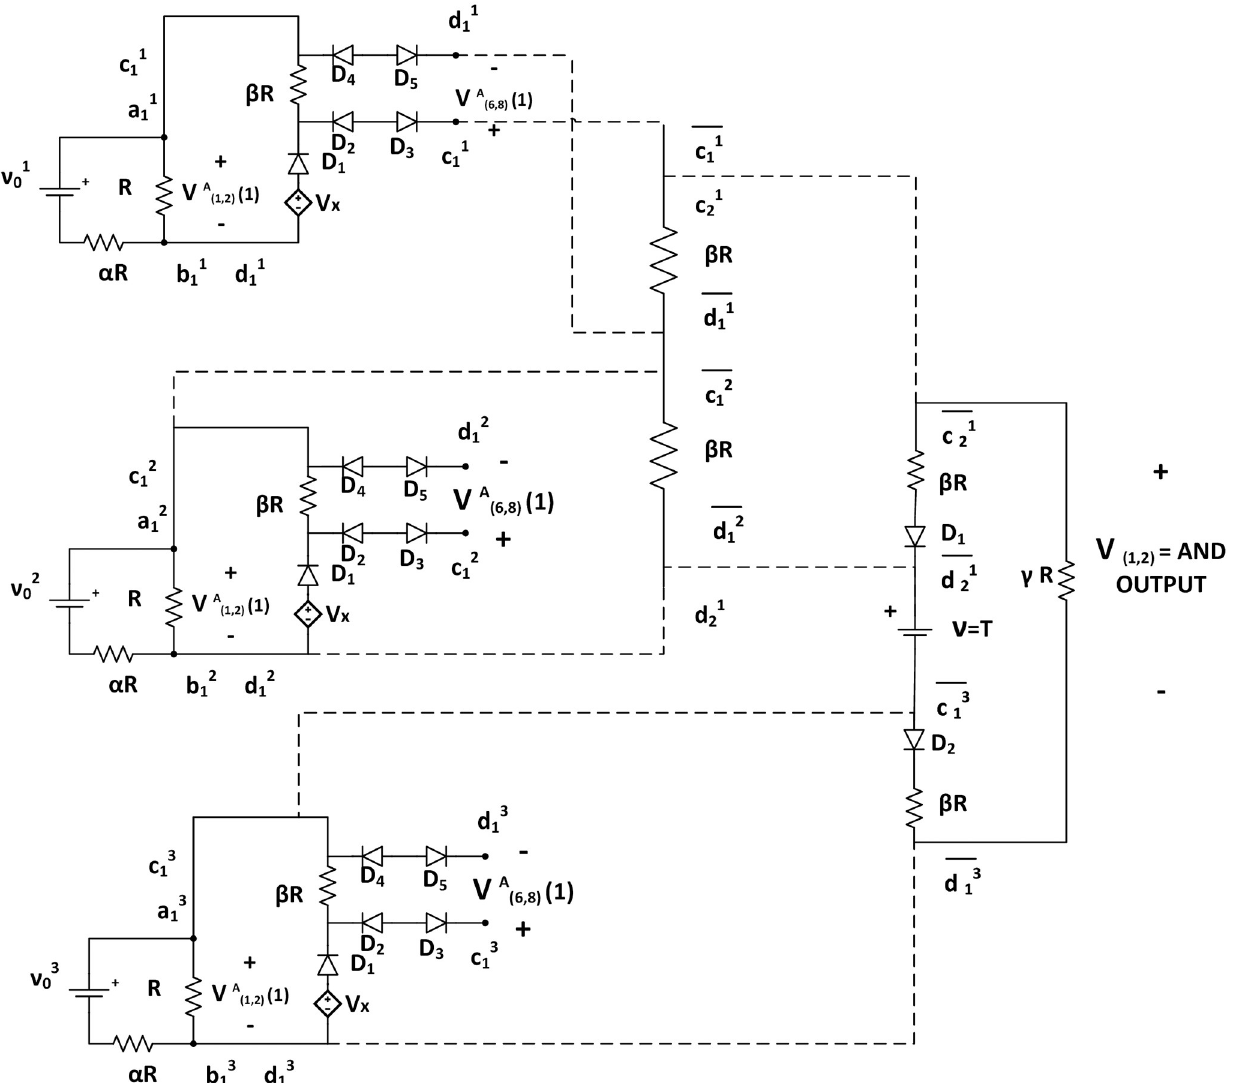
Fig 13. An example of SAT instance mapping to bcTAM SATISFIABILITY problem. Fig. shows the bcTAM implementation of an SAT example represented by Eq 15. Here, the first ladder is terminal, which is analogous to the negation of literal ( ¬ u 1 ). All other assemblies are still growing. The output of AND tile is > τ , and hence, it is a satisfiable circuit. Here, the dotted lines represent the attachment between two tiles using the